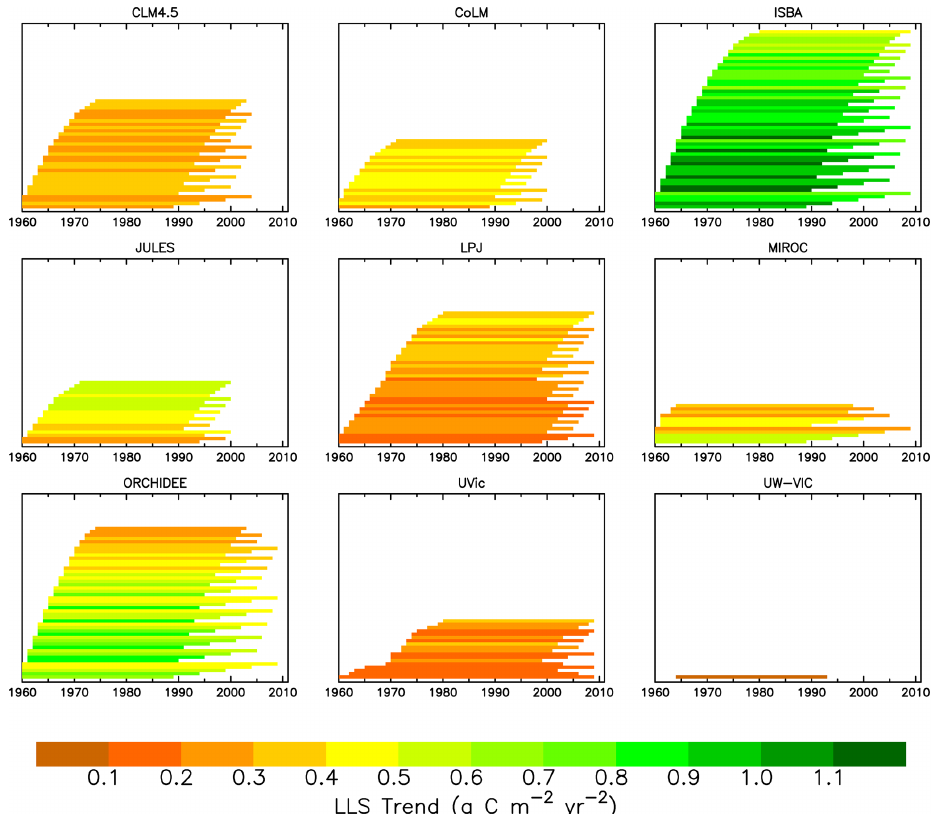
Figure 13. Magnitude of linear trend in NEP over given time interval for all trends significant at p < 0.05. For each model, linear trends are calculated for all time intervals of 20 years or more. For example, 1960–1979, 1960–1980, ... , 1990–2009. Intervals for which the trend is significant are marked with a line from the start to end year of the interval and shaded by the trend magnitude. As an example, one time interval is identified with a significant NEP trend for UW-VIC, from